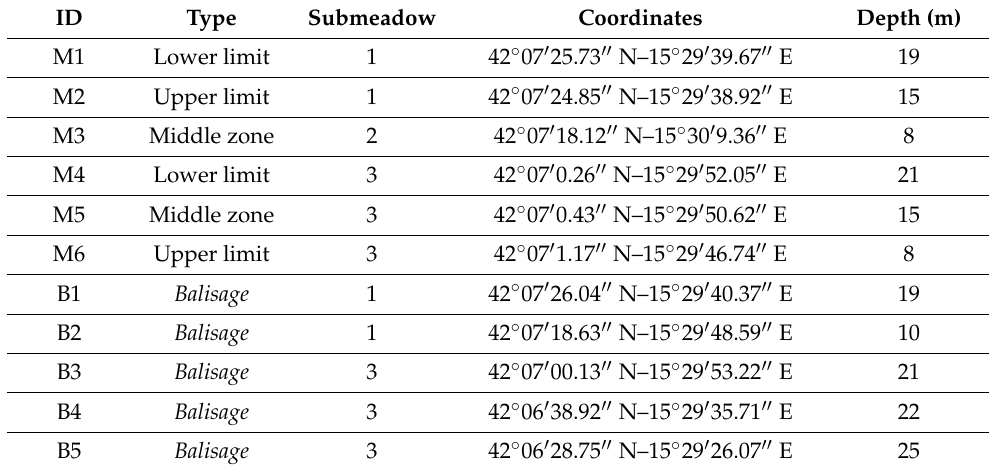
Table 1. ID, coordinates, and depth of sampling stations and balisage systems for each submeadow.